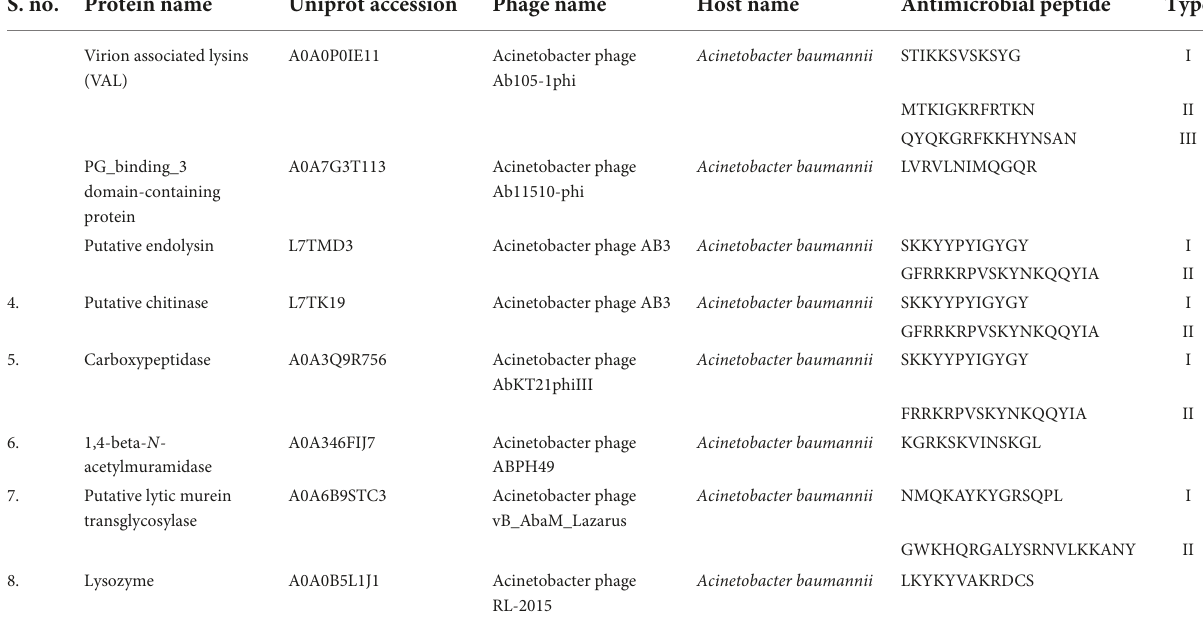
TABLE 2 Predicted antimicrobial peptides from the protein sequences of Acinetobacter baumannii specific phage. S. no. Protein